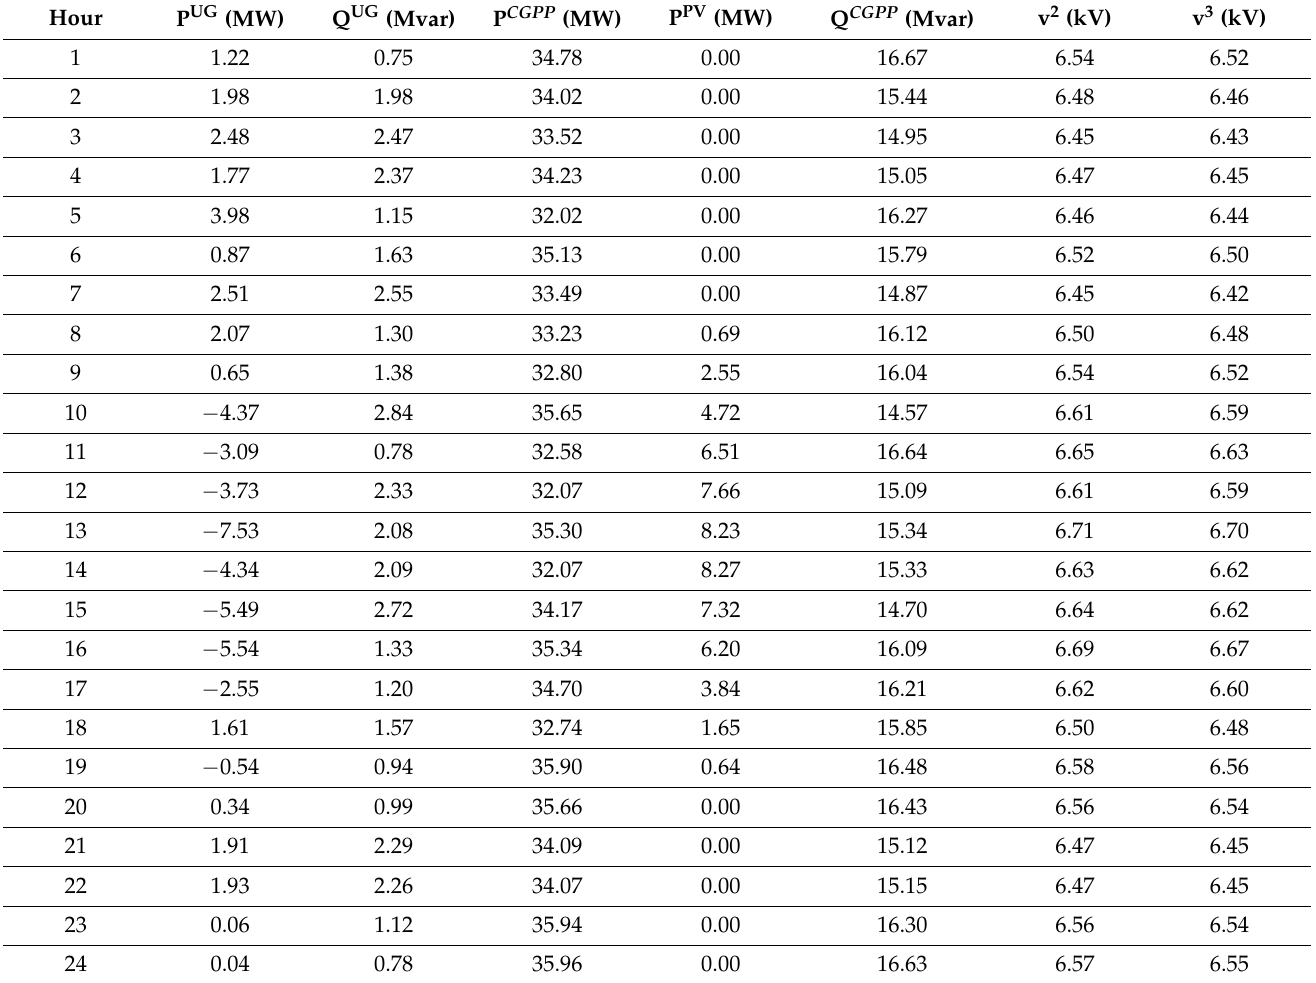
Table 6. FA results (-ve sign indicates the export of power).